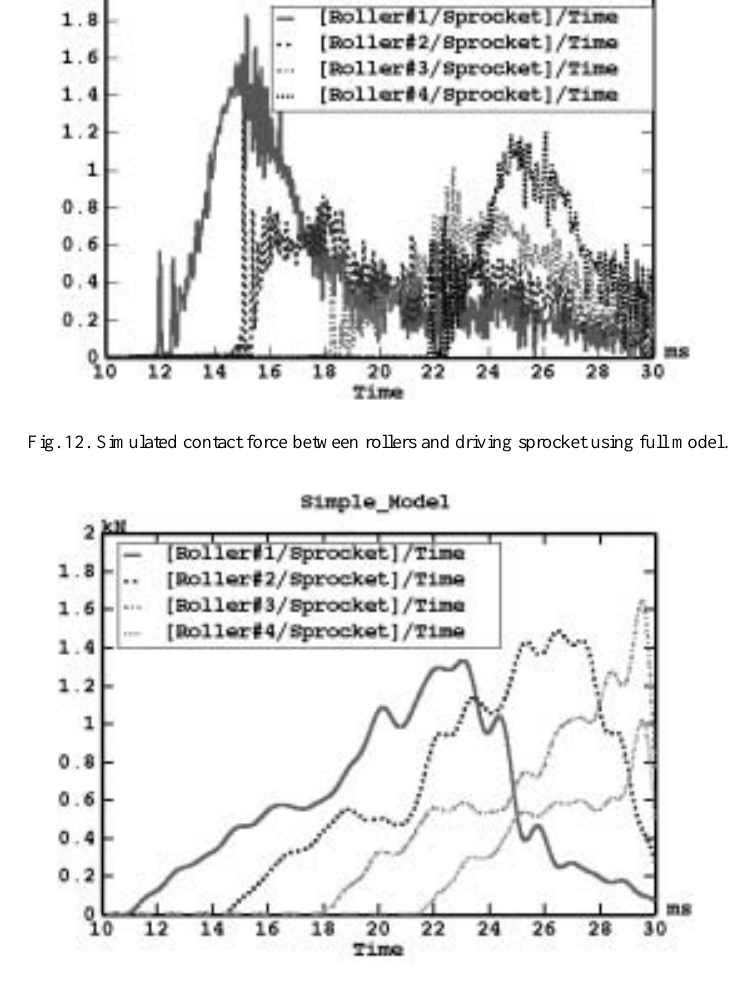
Fig. 13. Simulated contact force between rollers and driving sprocket using simple